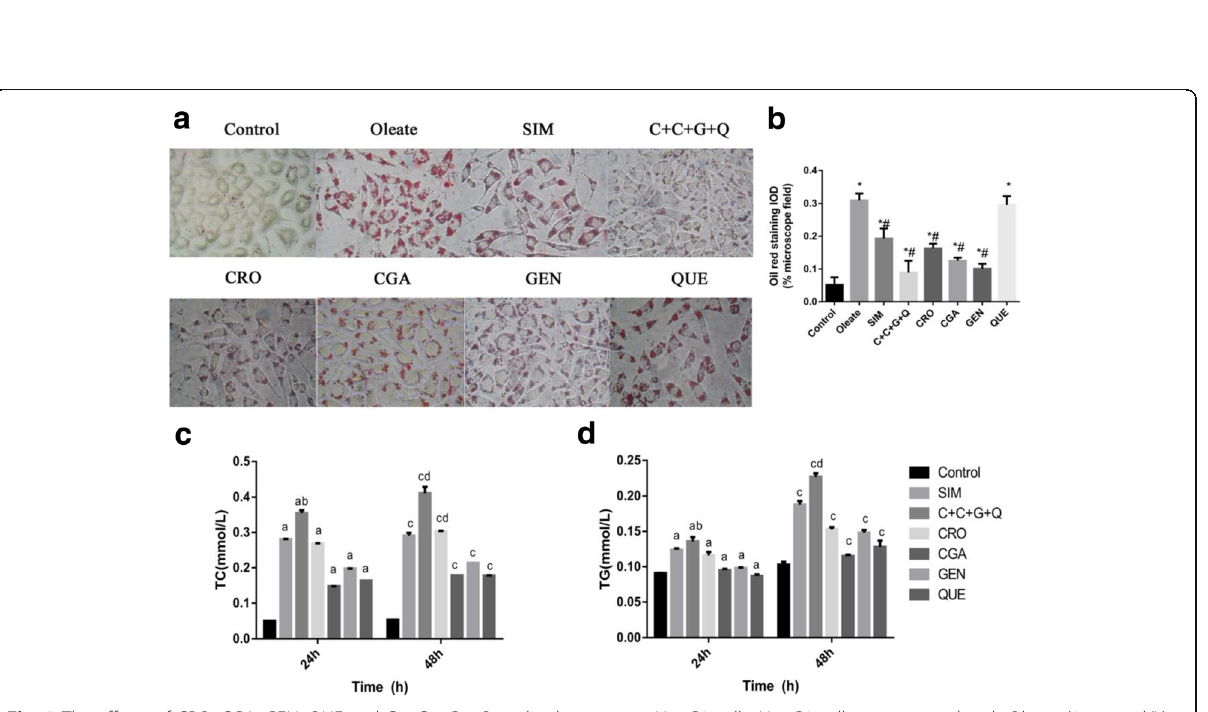
Fig. 3 The effects of CRO, CGA, GEN, QUE and C + C + G + Q on lipid content in HepG2 cells. HepG2 cells were treated with Oleate (0.1 mmol/L), SIM (10 μ mol/L), CRO (1 μ mol/L), CGA (30 μ mol/L), GEN (10 μ mol/L), QUE (10 μ mol/L) and C + C + G + Q (1 μ mol/L + 30 μ mol/L + 10 μ mol/L + 10 μ mol/L) for 24 h or 48 h. a After 48 h incubation with different drugs, the images of cells were observed by microscope at 250 × original magnification showing lipid accumulation in cells stained by Oil red O. b The comparison of integral optical density (IOD) for Oil red staining in cells. Effects of different drugs on the secretion of ( c ) TC and ( d ) TG were observed by HepG2 cells in minimum essential medium. Data are expressed as mean ± SEM from at least four independent experiments. * P < 0.05 vs. control, # P < 0.05 vs. Oleate. After 24 h, a P < 0.05 vs. control, b P < 0.05 vs. SIM. After 48 h, c P < 0.05 vs. control, d P < 0.05 vs.